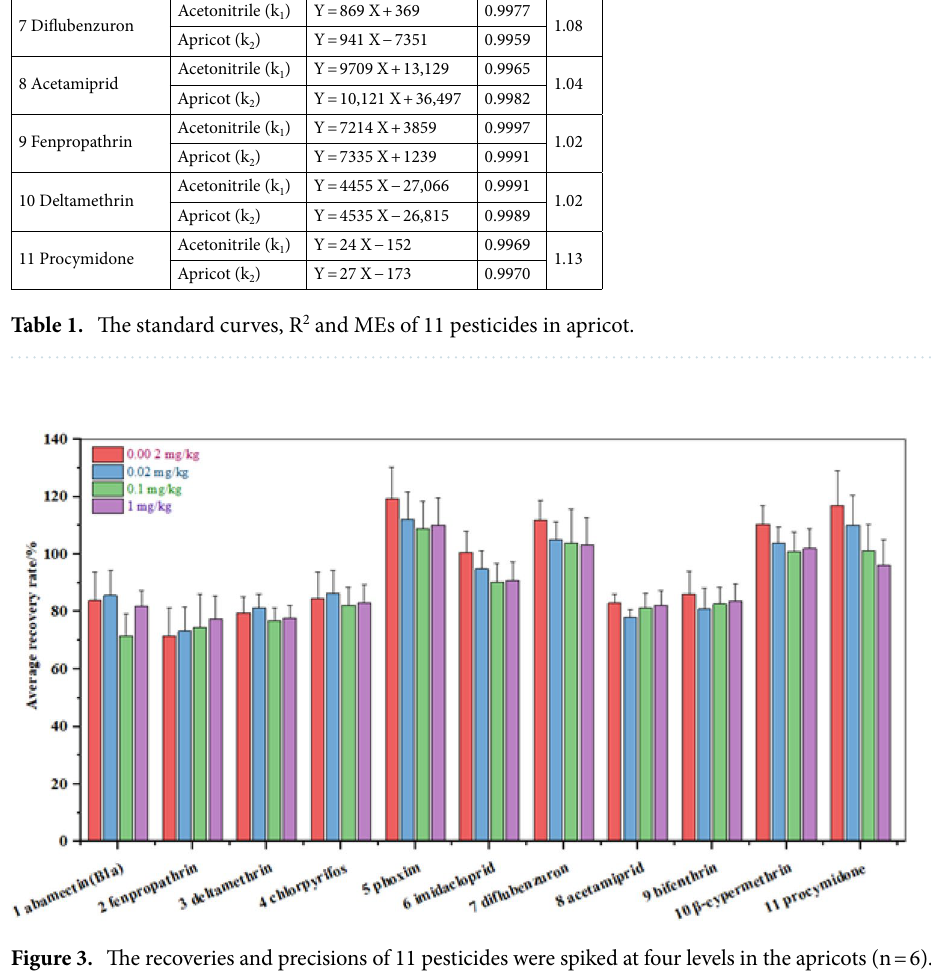
Figure 3. The recoveries and precisions of 11 pesticides were spiked at four levels in the apricots (n =